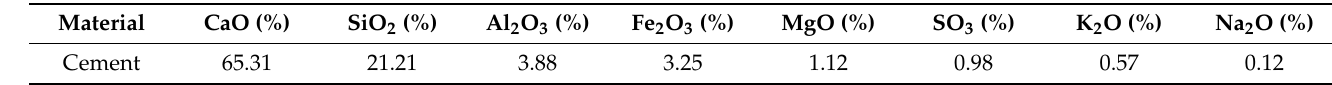
Table 1. Chemical compositions of cement.